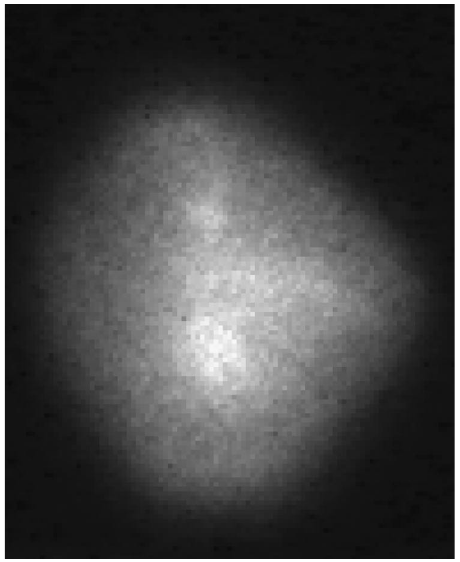
FIG. 2. Cross sectional image of the total HCX beam intensity at the location of Fig. 1. The scale for this image is 4.9 cm (horizontal) by 6.0 cm (vertical).